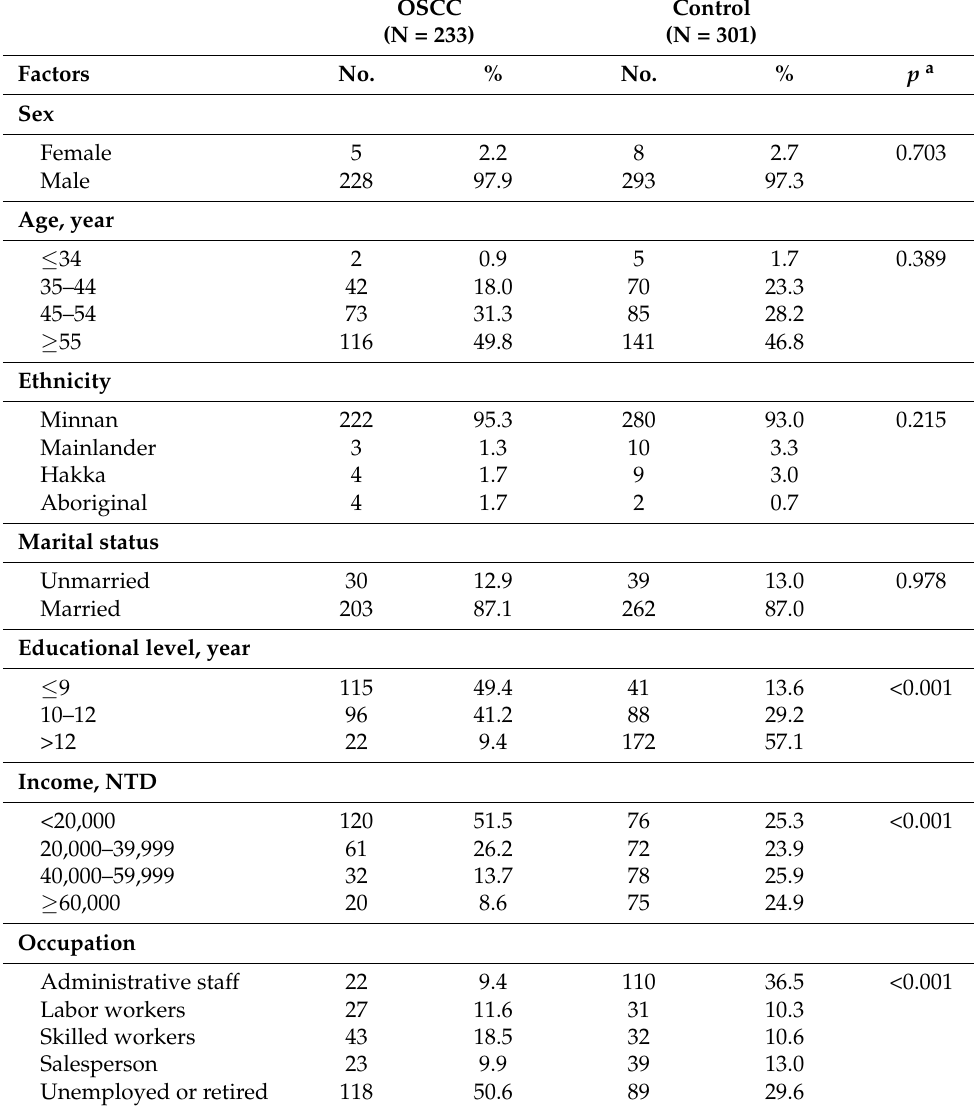
Table 2. The distribution of demographic factors in oral squamous cell carcinoma patients and